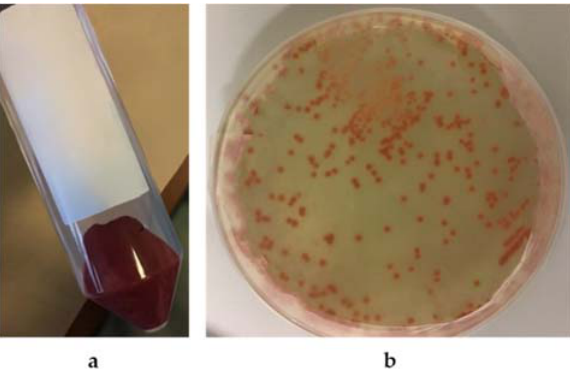
Figure 8. The 5AG strain’s cellular localization of selenite reduction products in medium A. Panel ( a ) cells incubated in liquid medium; Panel ( b ) cells incubated in solid medium. cells incubated in liquid medium; Panel ( b ) cells incubated in solid medium.